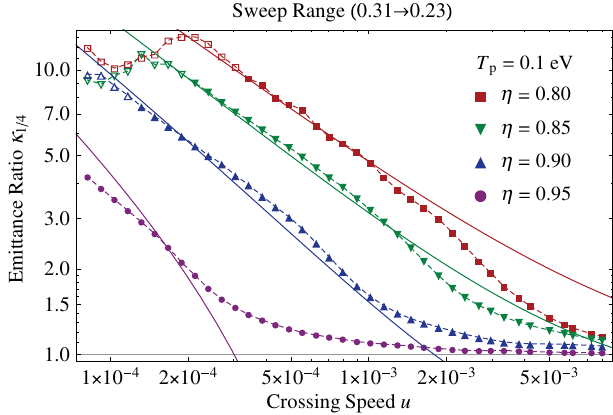
FIG. 19. WARP simulation data of quarter-integer resonance crossing. The u dependence of the emittance growth rate (cid:8) 1 is plotted for four different initial values of (cid:3) . The initial plasma temperature T p has been set at 0.1 eV in all simulations here to minimize particle losses. Similarly to the examples in Fig. 16, data points with finite particle losses are indicated by open symbols. The solid lines are obtained from the scaling law in Eq. (3) together with Eq.